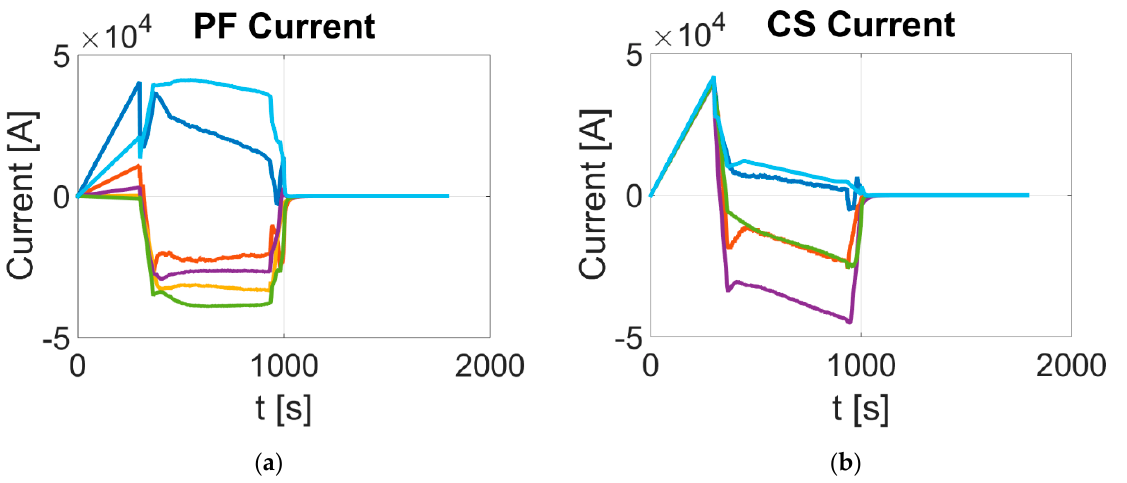
Figure 10. Testcase#1. The PF ( a ) and CS ( b ) excitation current during the plasma event (different colors are used for different coils).